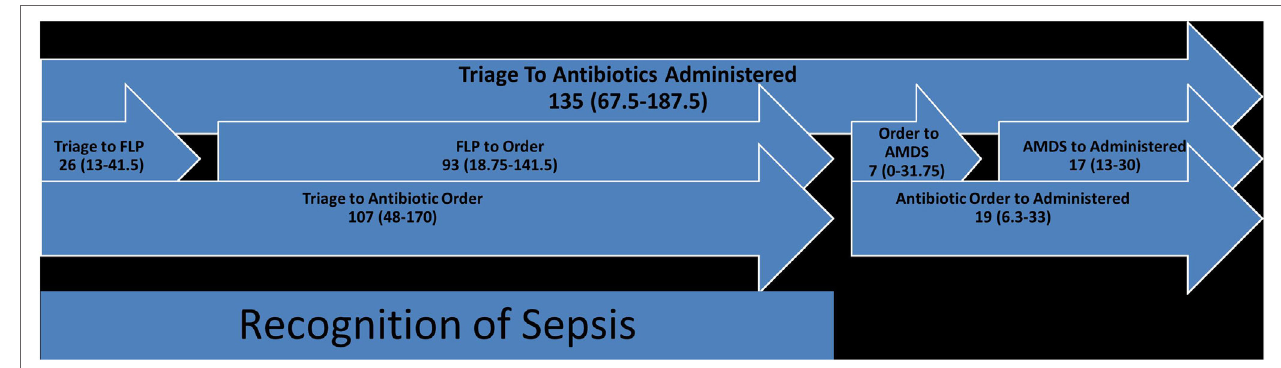
Figure 3 | Antibiotic time course (FLP, front-line physician, usually ER-physician; AMDS, automated medication dispensing system) (each numerical value in the figure represents time in